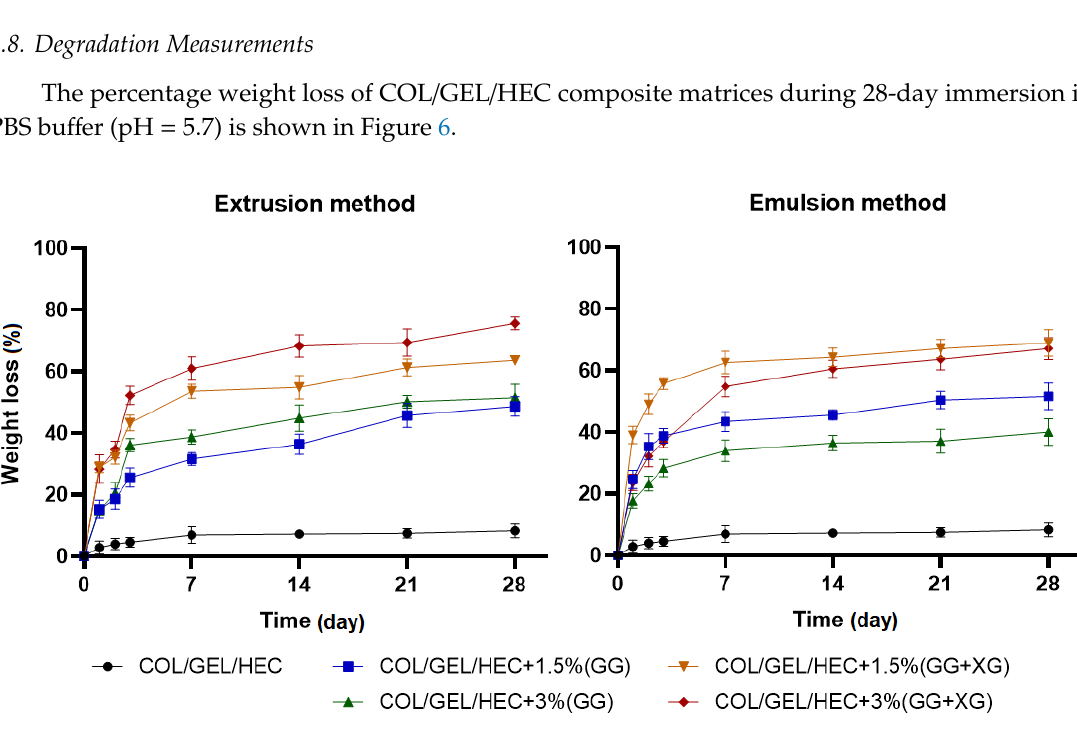
Figure6. ThevaluesofweightlossduringthedegradationofCOL / GEL / HECmatriceswithincorporated Figure 6. The values of weight loss during the degradation of COL/GEL/HEC matrices with microspheres obtained by extrusion and emulsion incorporated microspheres obtained by extrusion and emulsion method.